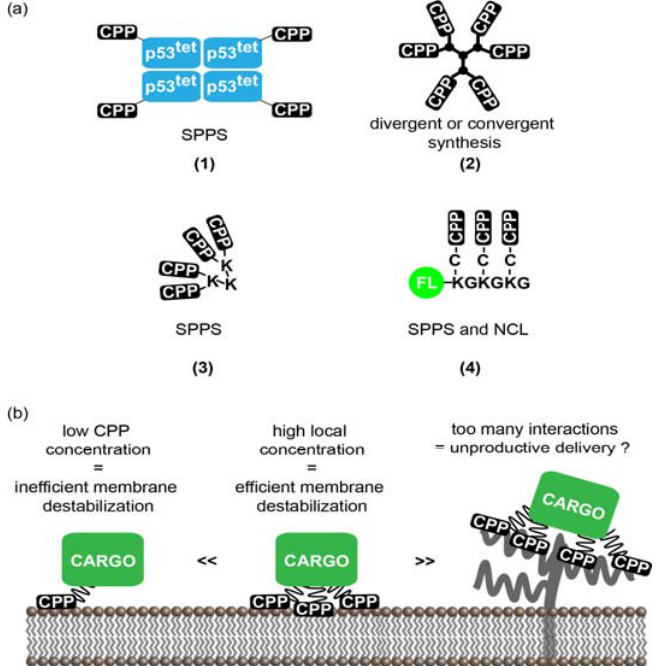
Figure 2. MCPPs systems and their interactions with membranes. (a) Strategies used to generate MCPPs. From left to right: (1) The p53 tet -CPP system involves connecting the tetramerization domain from the human tumor repressor protein p53 to a CPP. The peptide sequence is generated using SPPS. After purification of the peptide sequence, p53 tet self- assembles into a tetramer producing a tetravalent CPP. (2) Loligomers are a “squid-like” MCPP system. The CPP is attached on the surface of a polylysine branch scaffold. The scaffold and the peptide are generated using SPPS. The number of branches of this MCPP system will depend on the number of Lys coupling steps. (3) The branched CPP system involves the generation of a peptide scaffold of Lys( ε -NH-Cys)Gly repeats to which a CPP-thioester is added using native chemical ligation (NCL). The peptides were generated using SPPS although production of recombinant peptide or protein thioesters is possible using intein fusions [100,101]. A fluorophore was added on the N -terminal end of the scaffold peptide to serve as both an imaging agent and a small model cargo. (4) Dendrimers are MCPPs having a “tree-like” shape and are usually generated using divergent or convergent methods. CPPs have been attached to the surface of